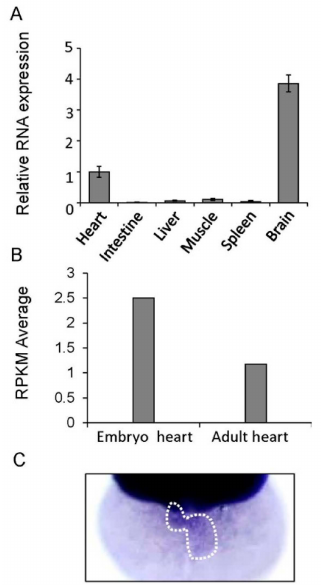
Figure 2. Assessment of the cardiac expression of gatad1 in zebrafish. ( A ) The relative expression level of gatad1 in different tissues were revealed by real-time RT-PCR using 18s as internal control. Cardiac expression was defined as 1 and used as a reference. The brain has the highest gatad1 expression; ( B ) Different expression levels of gatad1 in embryonic and adult zebrafish hearts were revealed by RNA sequencing. gatad1 expression in the embryonic heart is higher than that in the adult heart; ( C ) Cardiac expression of gatad1 transcripts was also revealed by in situ hybridization in 2 dpf zebrafish embryos. RPKM: number of reads per kilobase per million